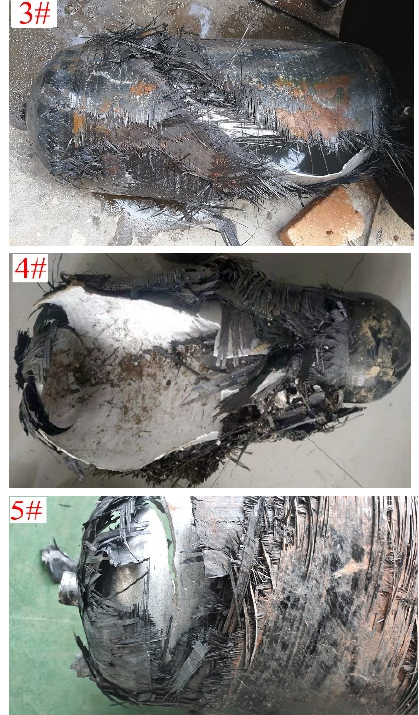
Figure 7. Failure modes of COPVs 3#–5#.